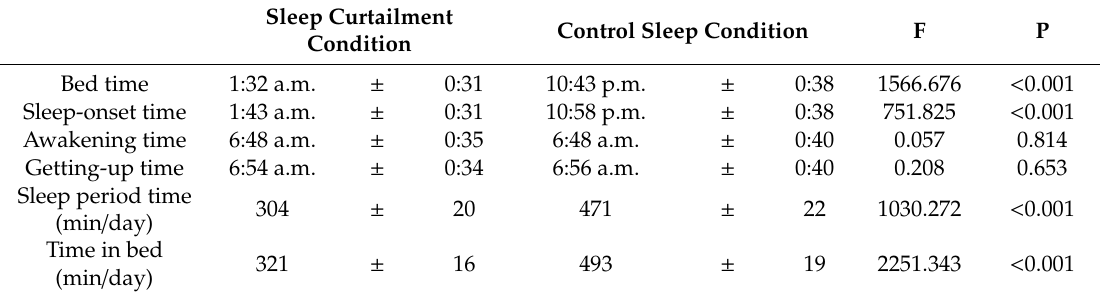
Table 2. Assessment of the objective sleep characteristics of participants across three nights in the sleep curtailment and control sleep